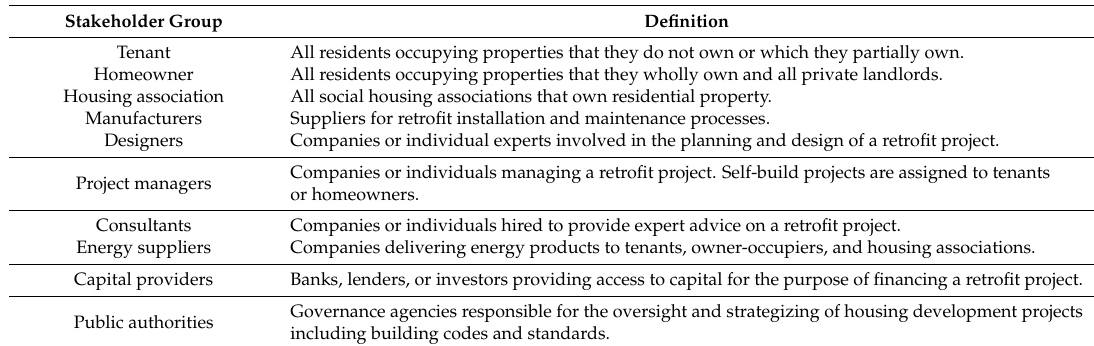
Table 2. Main actors in the UK retrofit sector (adapted from